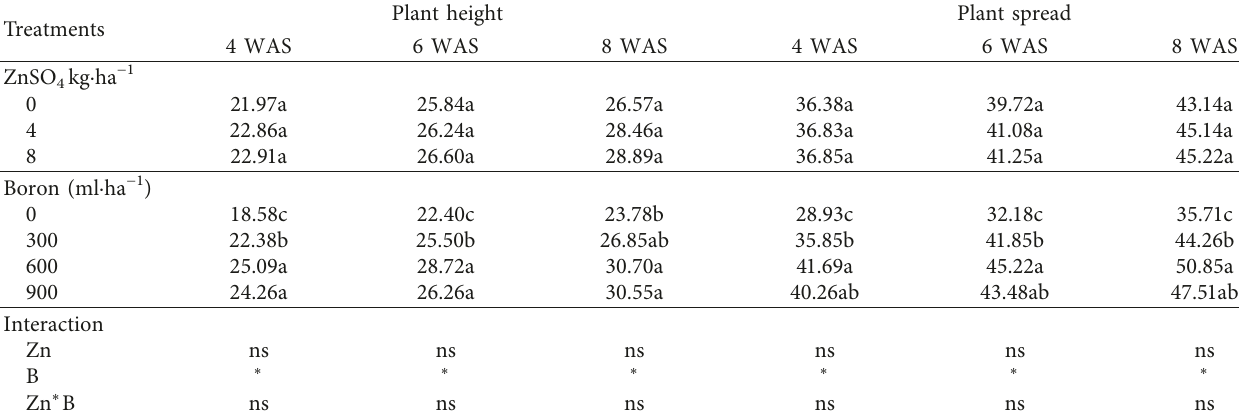
Table 3: Effect of application of zinc and boron fertilizers on vegetative parameters of groundnut (pooled data of 2016 and 2017 cropping seasons).